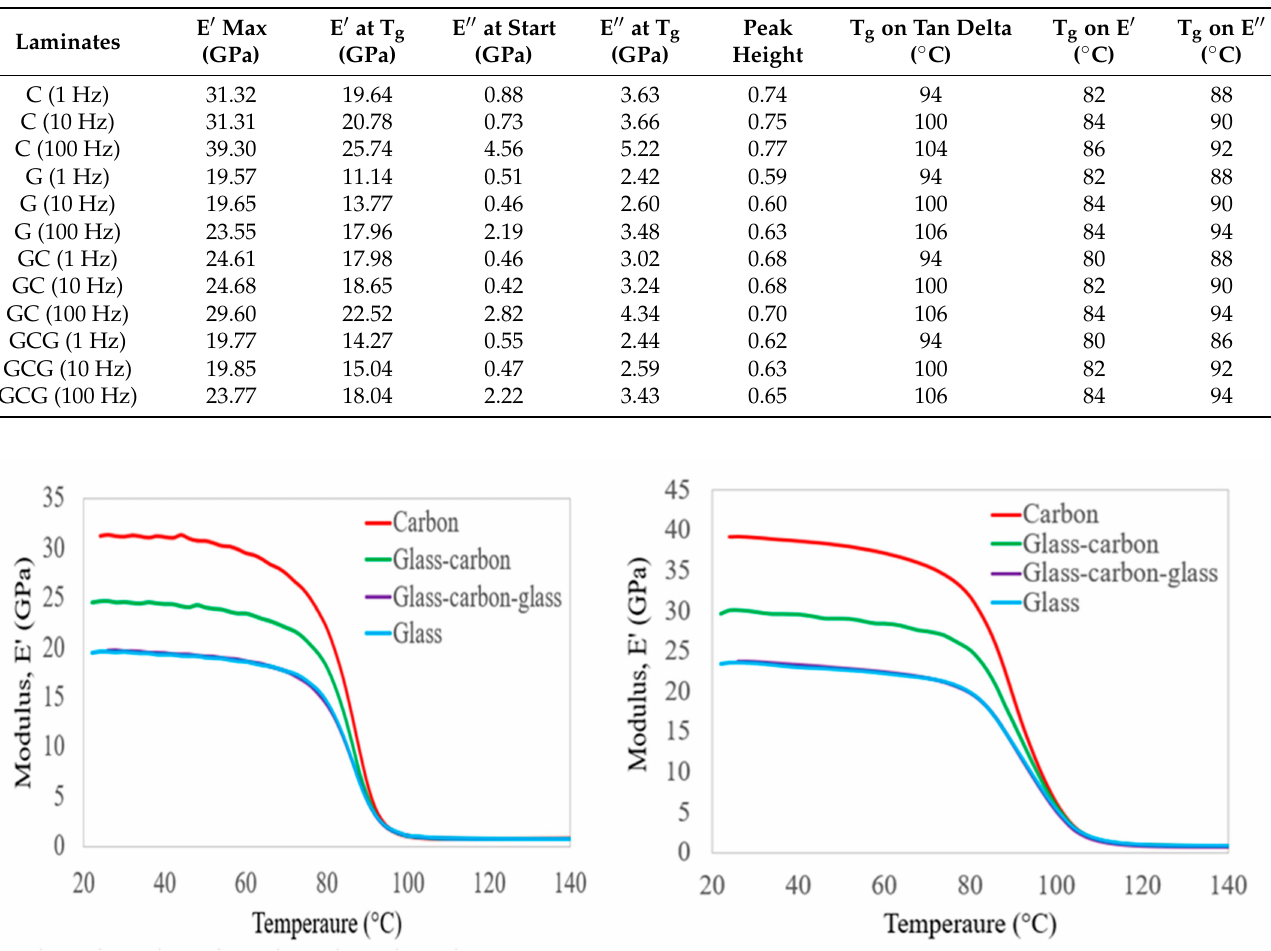
Table 7. Mechanical responses of C, G, GC, and GCG laminates on storage modulus (E (cid:48) ), loss modulus